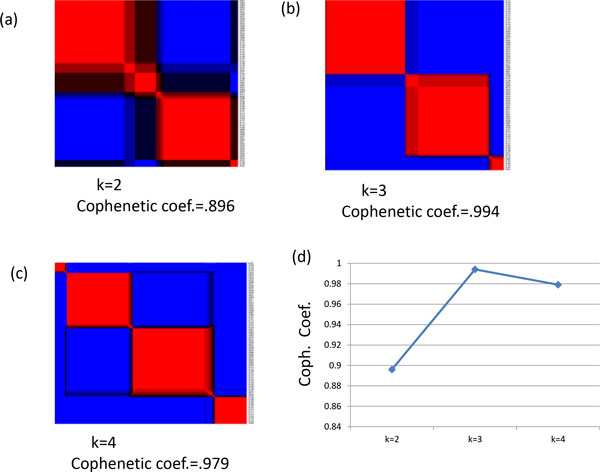
Plot of NMF performances and Cophenetic coefficients correlation. (a) k=2 (b) k=3 and (c) k=4 where  k is number of clusters. (d) Illustration of Cophenetic coefficients for number of clusters.